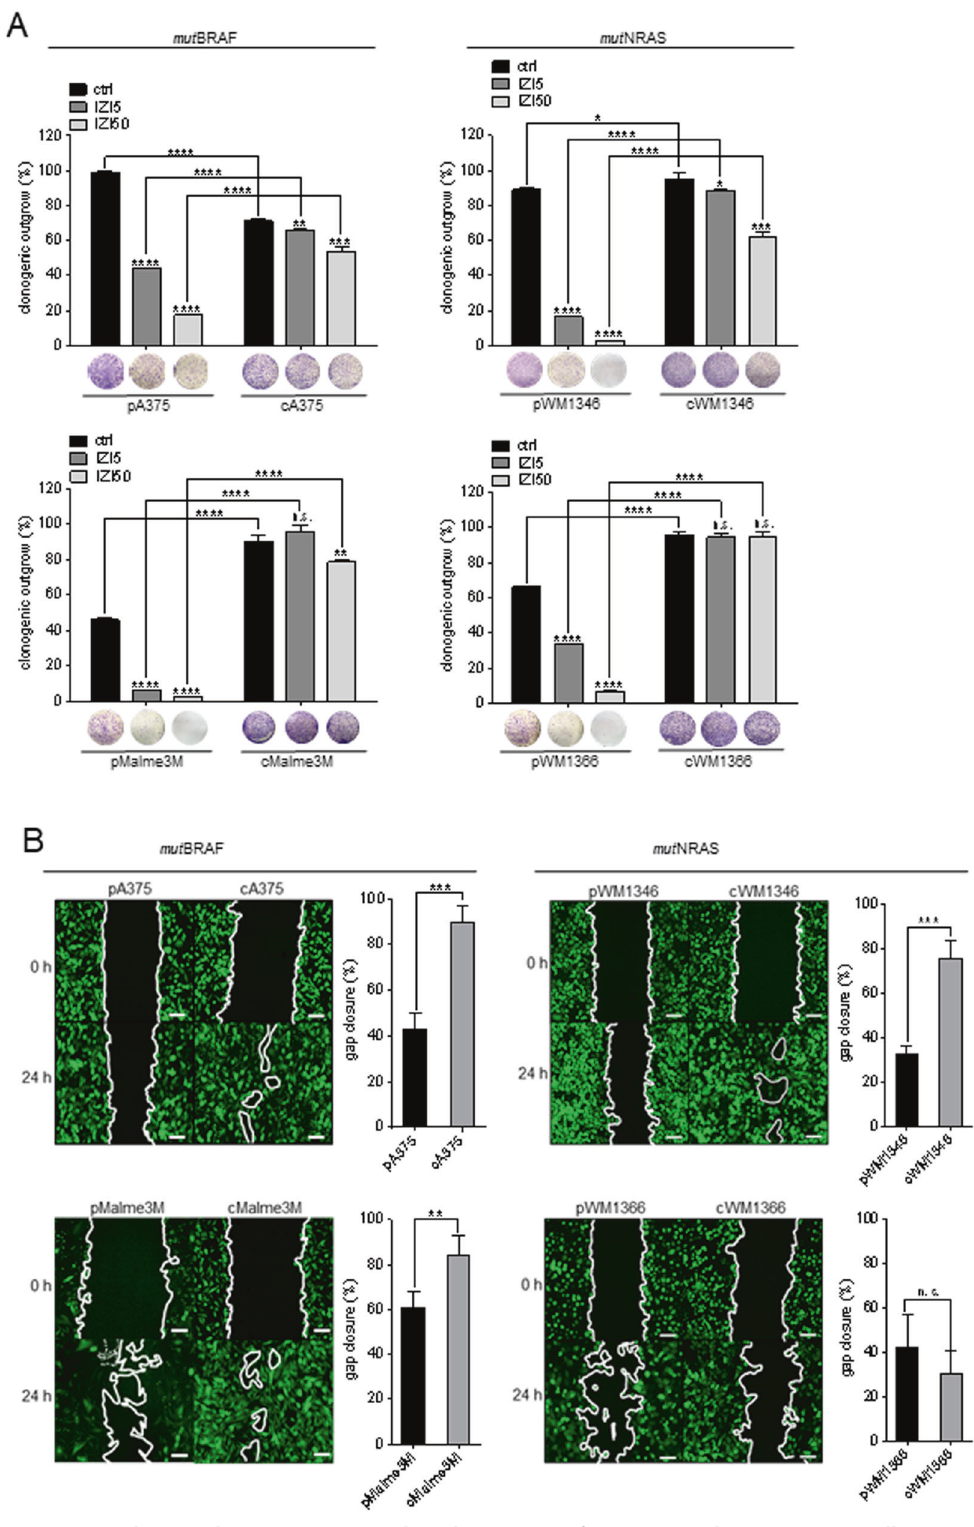
Fig. 3 Conditioning to IZI5 enhances clonogenic outgrowth and migration of mut BRAF and mut NRAS MM cells. A Parental (p) and IZI5- conditioned (c) MM cells seeded at 10% con fl uency were left untreated or stimulated with IZI5 and IZI50, respectively, every other day. After 8 days, colonies were stained with crystal violet, and absorbance of eluted crystal violet at 595 nm was quanti fi ed ( n = 3) (* p ≤ 0.05; ** p ≤ 0.01; *** p ≤ 0.001; **** p ≤ 0.0001; n.s. = not signi fi cant). B Migration of untreated GFP-expressing parental (p) and IZI5-conditioned (c) cells was monitored by scratch assay (scale bar = 100 µm) and gap closure quanti fi ed after 24 h ( n = 3: ** p ≤ 0.01; *** p ≤ 0.001; n.s. = not signi fi cant).